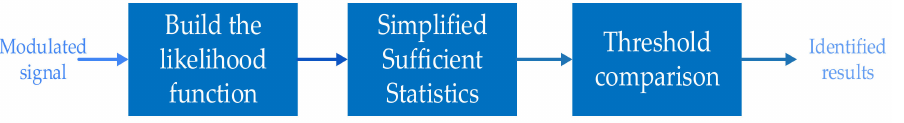
Figure 2. Flowchart of the likelihood modulation identification